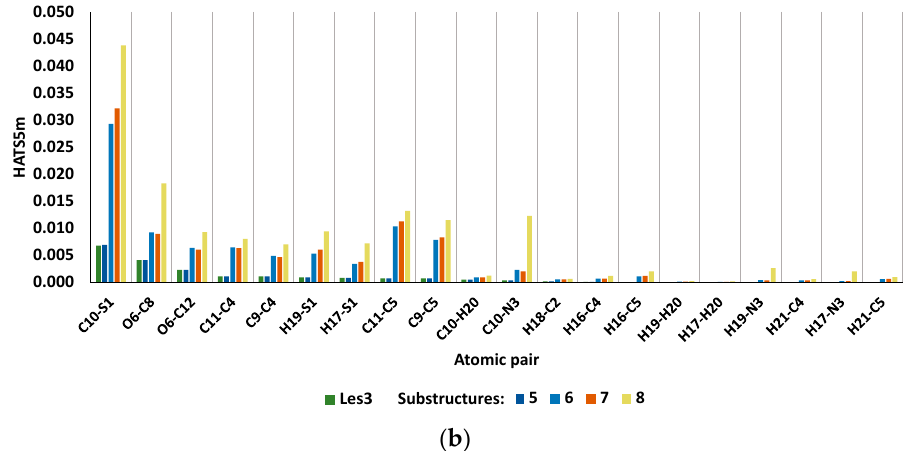
Figure 12. The contributions of Les3 (Les-3021) different fragments ( a ) and atomic pairs of orange-red ( b ) in the descriptor value. The numbering of atoms is shown in Figure 10.